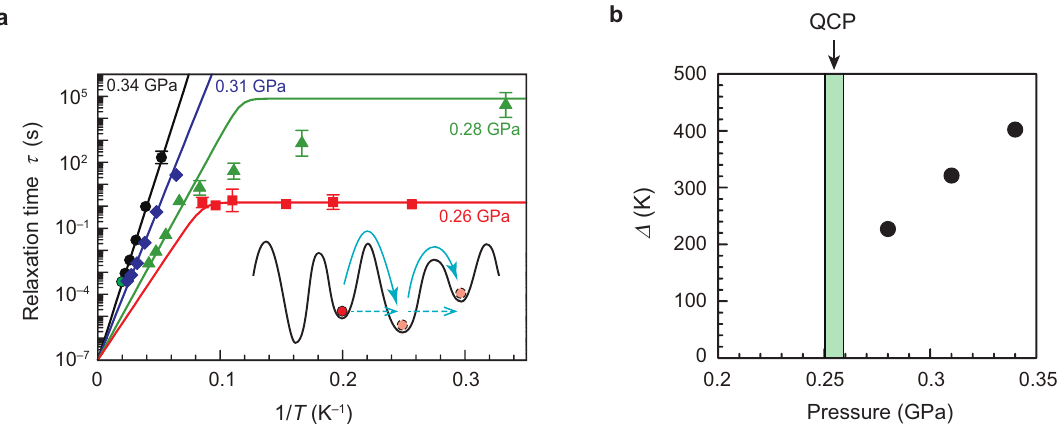
Figure 6. ( a ) Classical-quantum crossover of the ferroelectric domain-wall dynamics. The lines represent fits to Matthiessen’s rule: 1/ τ = 1/ τ classical + 1/ τ quantum , where τ classical follows the Arrhenius law and τ quantum is constant at a given pressure. The inset shows a schematic diagram comparing the classical thermally activated creep (solid arrows) with the quantum tunneling creep (broken arrows) of a domain wall (modeled as a particle). The multi-valley schematic represents a multidimensional potential landscape. ( b ) Pressure dependence of ∆ , derived from ( a